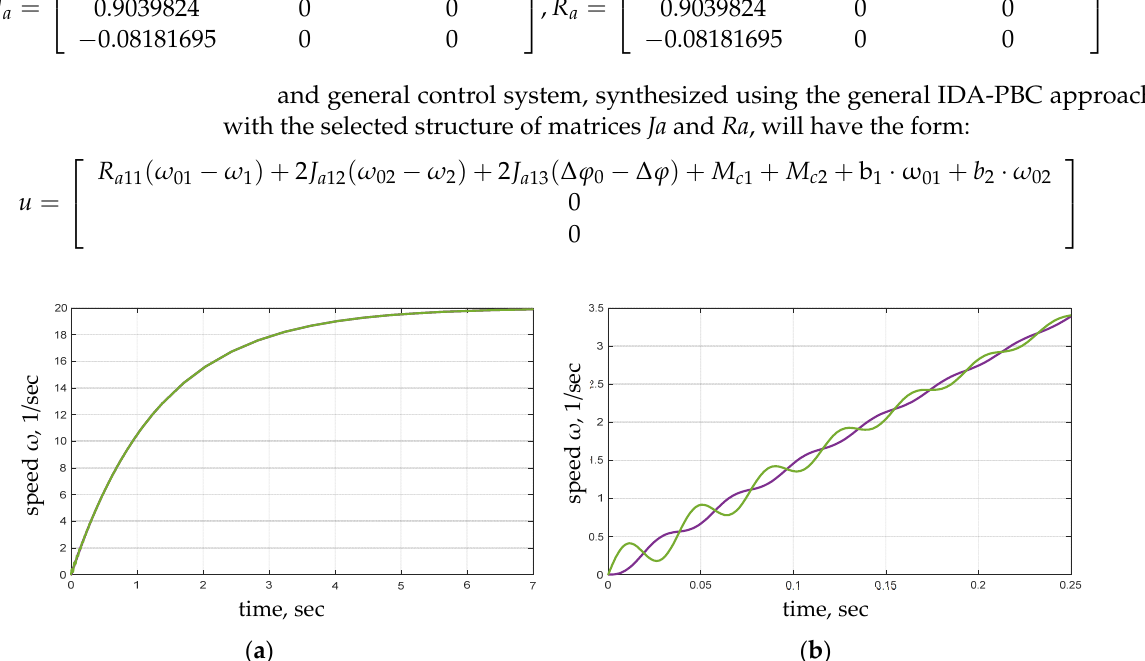
Figure 1. Dependences of change in speeds of the first (green) and second (purple) masses during acceleration: ( а ) acceleration to the desired value; ( b ) the beginning of the acceleration process.